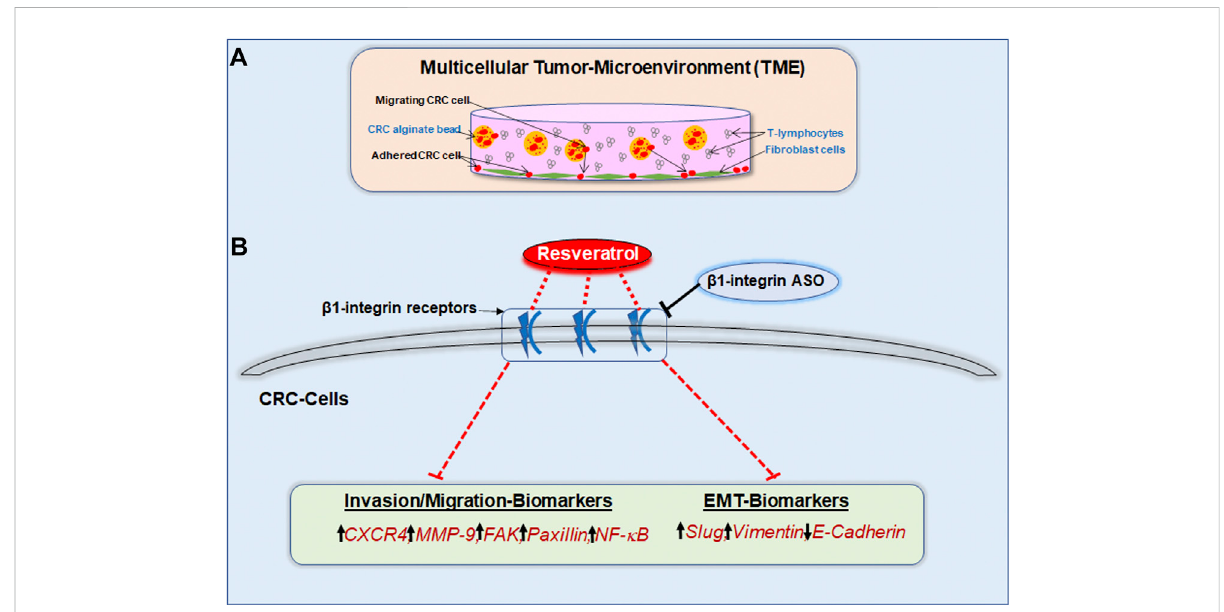
FIGURE 10 (A) Study model of the pro-in fl ammatory 3D-tumor microenvironment consisting of a fi broblast monolayer, fl oating T-lymphocytes in cell culturemediumandCRCcellsencapsulatedinalginate. (B) Graphicaloutcomeofresveratrol ’ santi-invasive,anti-metastasisandanti-EMTeffectsby using β 1-integrin receptors for signal transmission. The black arrows illustrate the biomarker situation within unaffected CRC cells. The red dashed lines show the modulatory effect of resveratrol on invasion-, migration- as well as EMT-parameters via β 1-integrin receptors. β 1-integrin-ASO can weaken this effect of resveratrol through β 1-integrin receptor